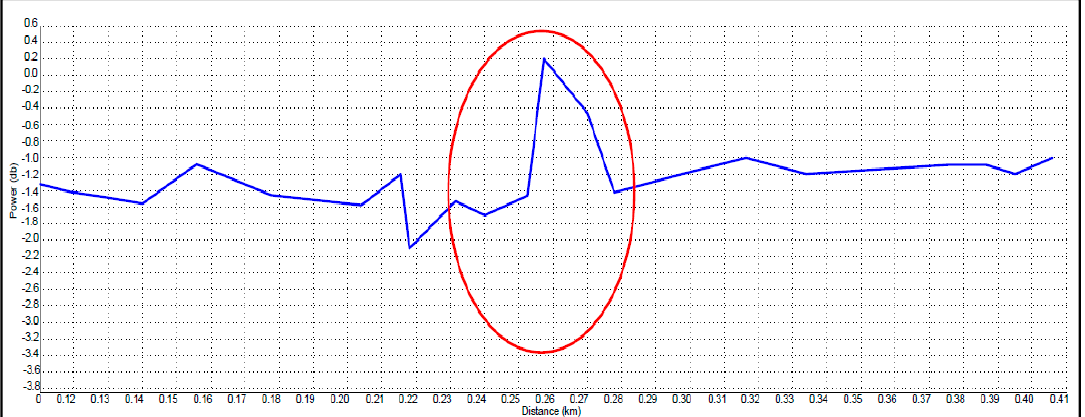
Table 9. The parameters and practical results detected at event 5.